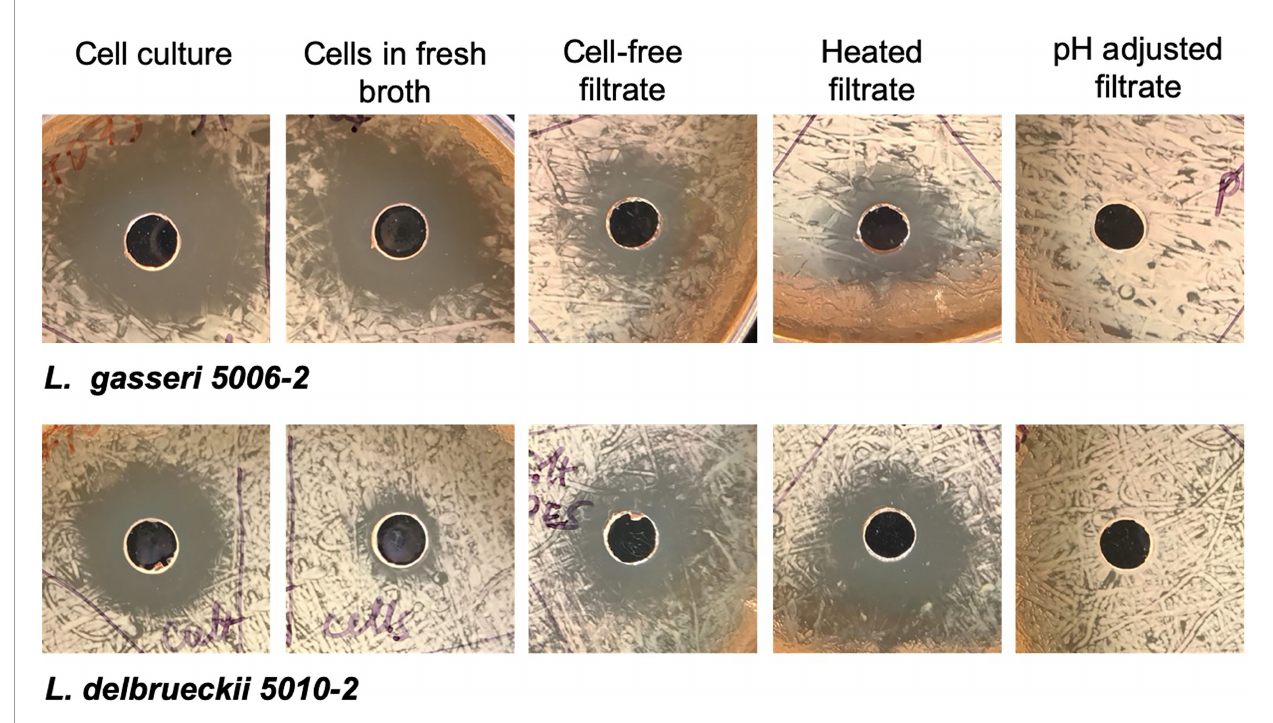
FIGURE 5 | Lactobacilli inhibition differs depending on culture treatment. Representative images from well-diffusion assays using whole cell culture, cells resuspended in fresh broth, cell-free fi ltrate, heated fi ltrate, and fi ltrate adjusted to a neutral pH. Images taken for 24 hrs. growth at